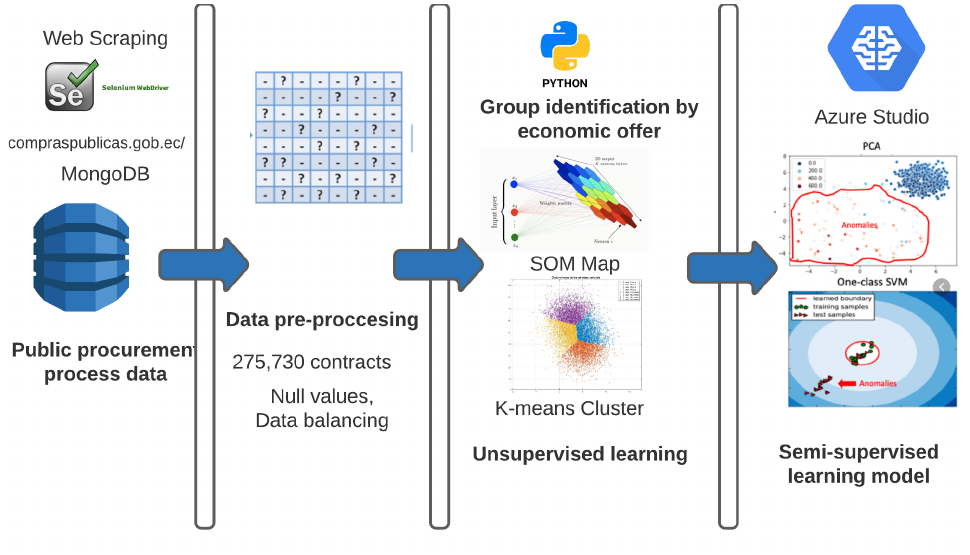
Figure 2. Diagram of the proposed methodology for find anomalies in qualification